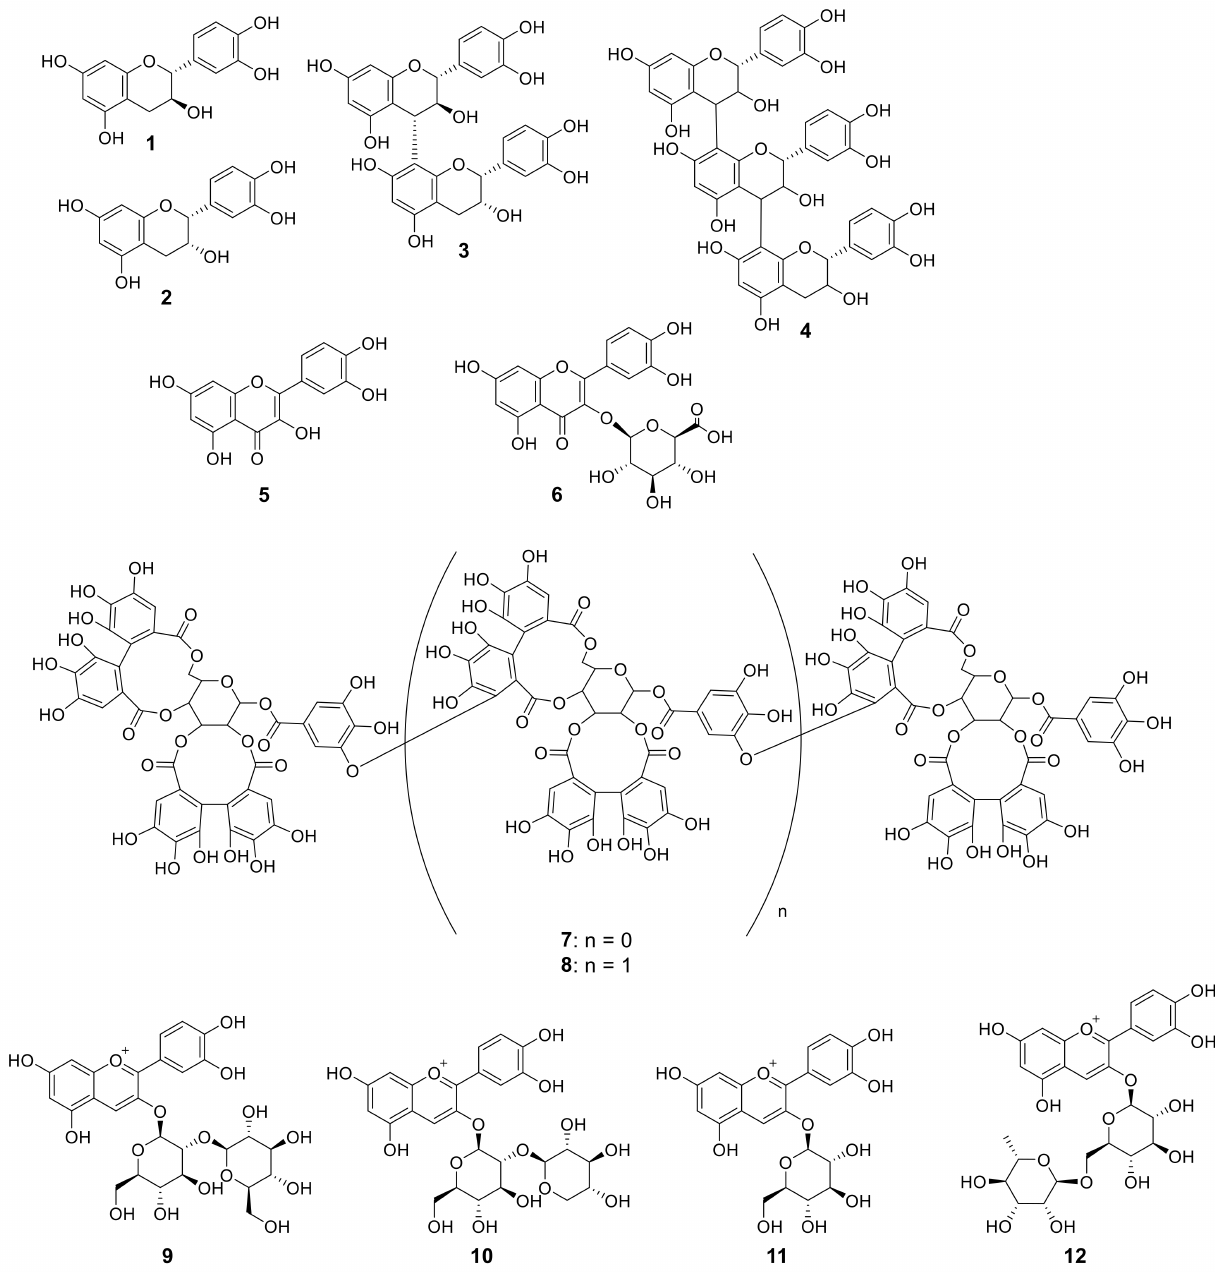
Figure 2. Chemical structures of the raspberry fruit polyphenol compounds ( 1 – 12 ). 1 : (+)-Catechin; 2 ( − )-epicatechin; 3 : procyanidin B4; 4 : flavan-3-ol trimer; 5 : quercetin; 6 : quercetin-3- O -glucuronide; 7 : lambertianin C; 8 : sanguiin H-6; 9 : cyanidin-3- O -sophoroside; 10 : cyanidin-3- O -sambubiside; 11 : cyanidin-3- O -glucoside; and 12 : cyanidin-3- O